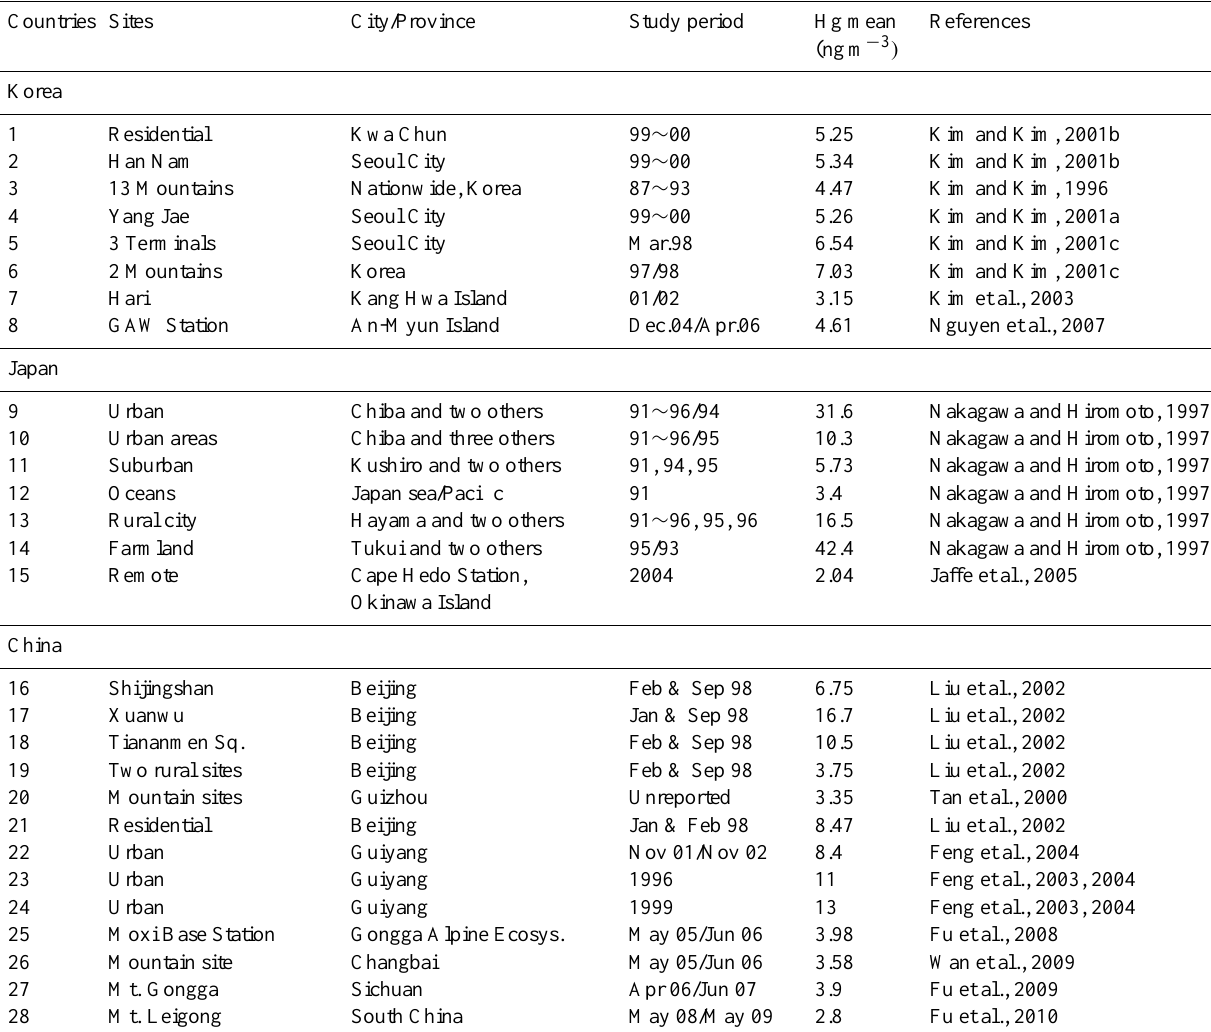
Table 6. Statistical summary of the mean concentrations of atmospheric Hg determined from a number of monitoring sites located in the East Asian